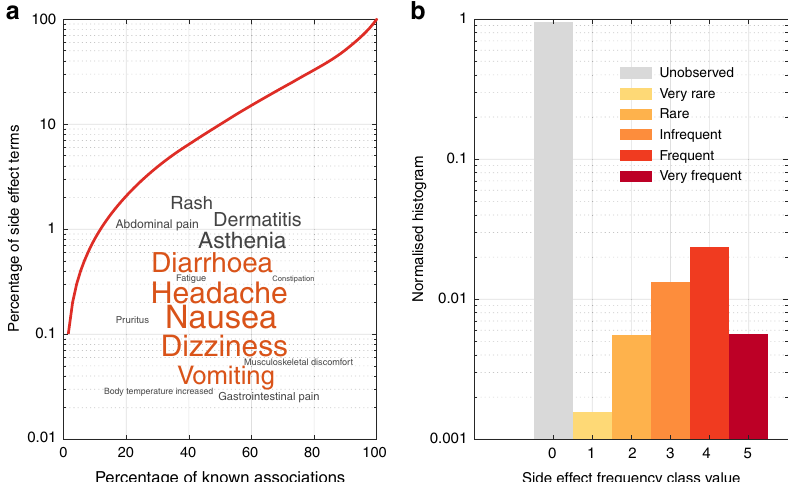
Fig. 1 Distribution of drug side effects in our data set. a Long-tailed distribution of side effects. Side effects in y -axis are ordered in decreasing order of popularity, i.e. the number of drugs in which a side effect appear. Inset. Word cloud of the 15 most popular side effects. The size of the word is proportional to its popularity; the fi ve most popular ones are coloured in orange. b Histogram of side effect frequency classes. The frequency of a drug side effect in the population can be very rare (<1 in 10,000), rare (1 in 10,000 to 1 in 1000), infrequent (1 in 1000 to 1 in 100), frequent (1 in 100 to 1 in 10) or very frequent (>1 in 10) — shown in shaded red bars. The remaining of the associations are unobserved (grey